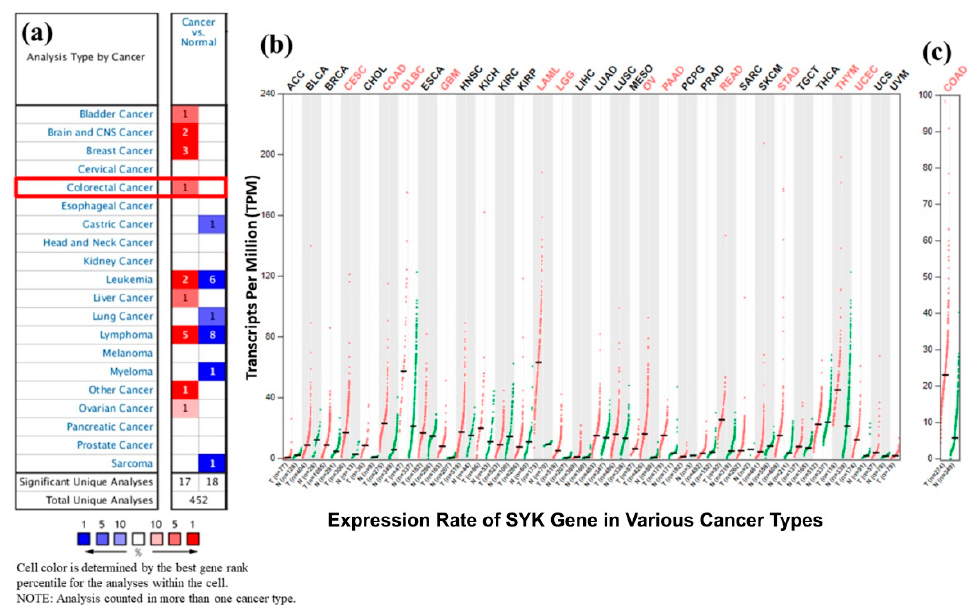
Figure 1. The mRNA expression profile of the SYK gene across various cancer types. ( a ) SYK mRNA expression in different cancer types from the Oncomine database, where the numbered red cells indicate the dataset with significant mRNA overexpression and blue cells indicate mRNA downregulation. ( b ) Pan-cancer expression profile analysis of the SYK gene from the GEPIA2 database in a dot plot, where each dots represent the expression of samples. mRNA expression is presented in transcript per million across different cancer types. ( c ) The transcription level in colorectal adenocarcinoma (COAD) patients with their corresponding normal samples from the GEPIA2 database. The red and green color dots represent tumor samples and paired normal tissues, respectively.